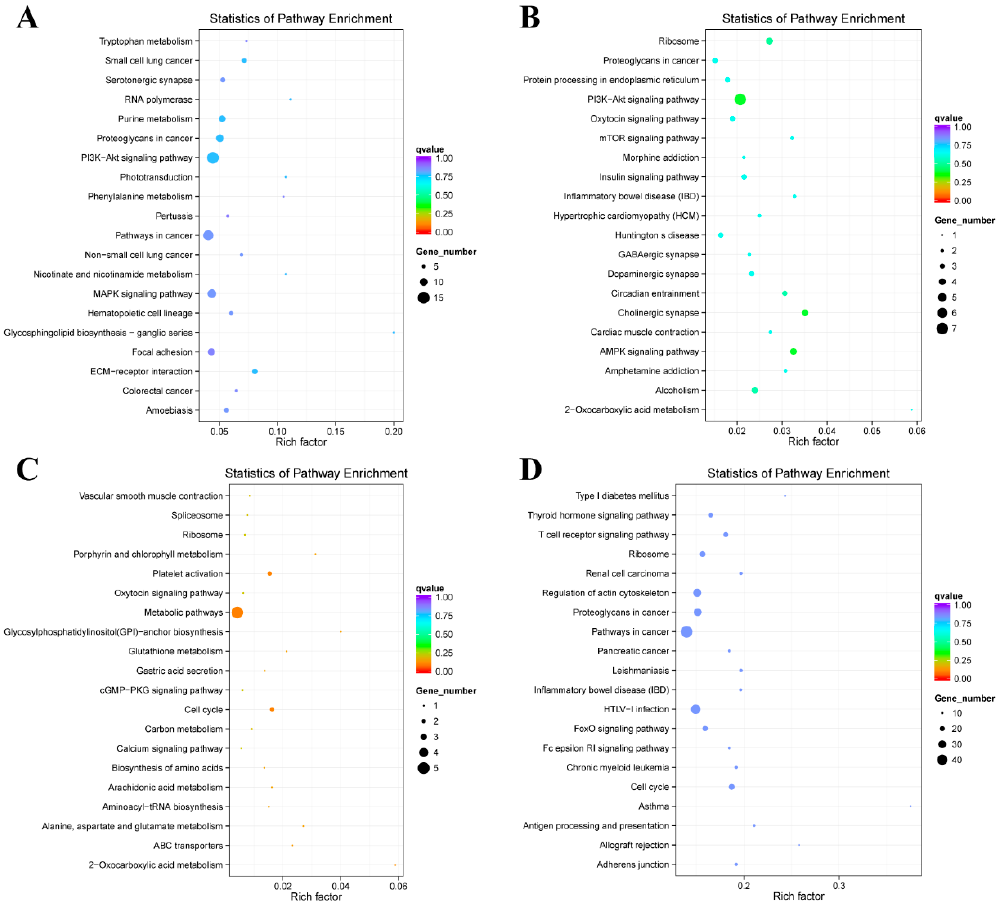
Figure 5. The Kyoto Encyclopedia of Genes and Genomes (KEGG) analysis of colocalized genes of differentially expressed lncRNAs. ( A ) The comparison of B vs S1. ( B ) The comparison of S1 vs S2. ( C ) The comparison of S2 vs S3. ( D ) The comparison of I vs S3.